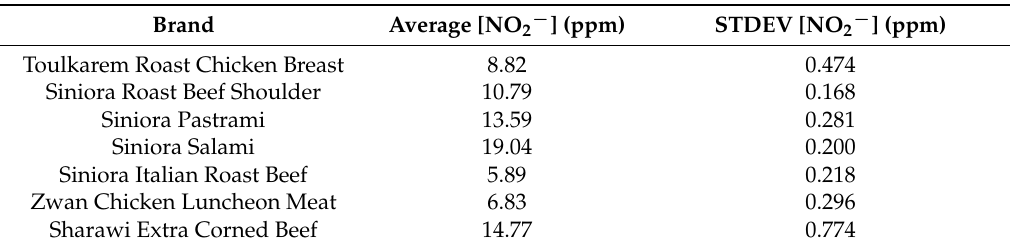
Table 5. The nitrite detected in various meat samples using the Lab on Chip (LOC).